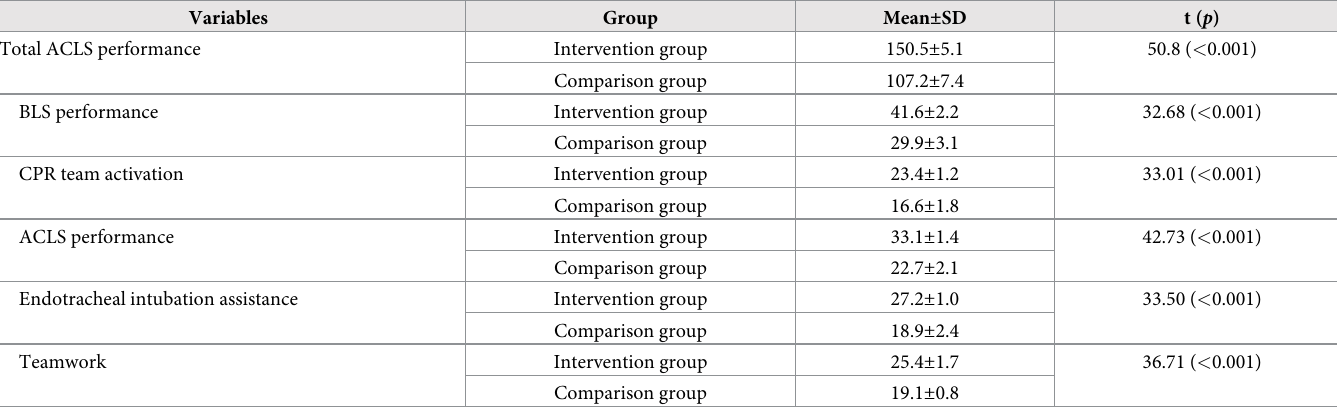
Table 2. Comparison of ACLS performance between the two groups (N = 226).